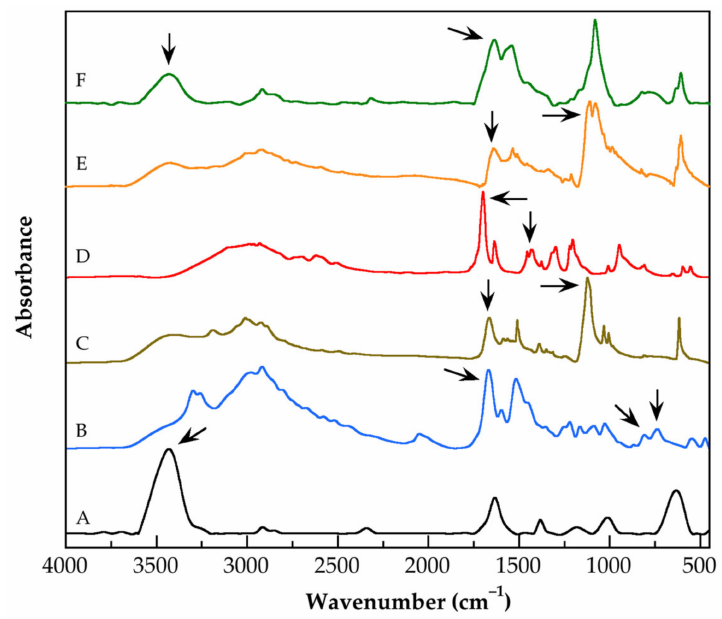
Figure 1. FT-IR spectra of CNTs oxid ( A ), CNTs OxCl ( B ), G 0.0 -CNTs-PAMAM-NH 2 ( C ), G 0.5 -CNTs- PAMAM-OCH 3 ( D ) G 3.0 -CNTs-PAMAM-NH 2 ( E ) and a mixture of G3.0-CNTs-PAMAM-NH 2 and MAA ( F